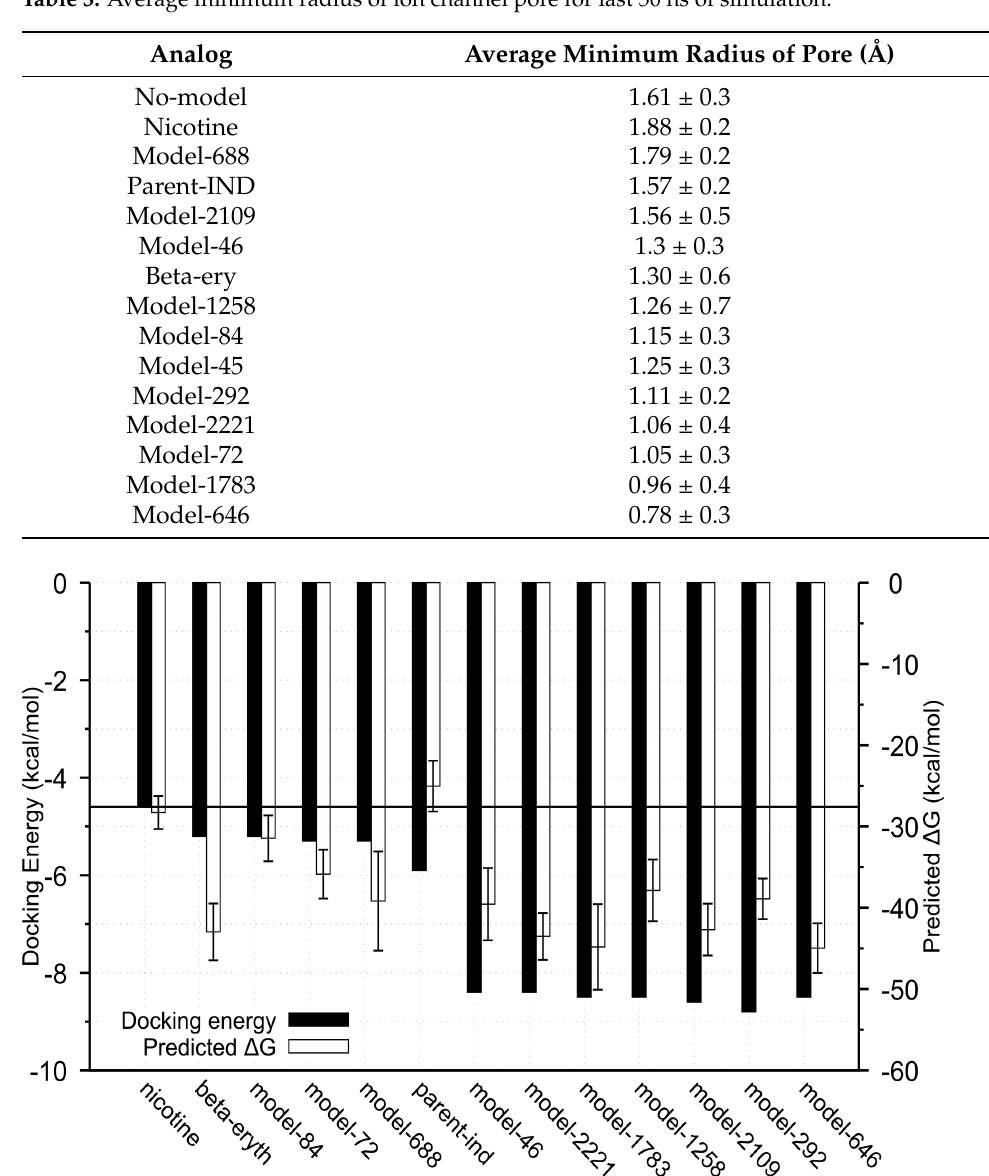
Figure 6. Comparison of docking energy and predicted binding energy from the MMGBSA method. Black horizontal line denotes docking energy of nicotine (classical ligand of the receptor). Model 84, 72 and 688 are the lowest ranked analogs and are added for comparison. [beta-erthry = Dihydro- beta-erythroidine. The predicted binding energies are shown as Mean ± SD; n =